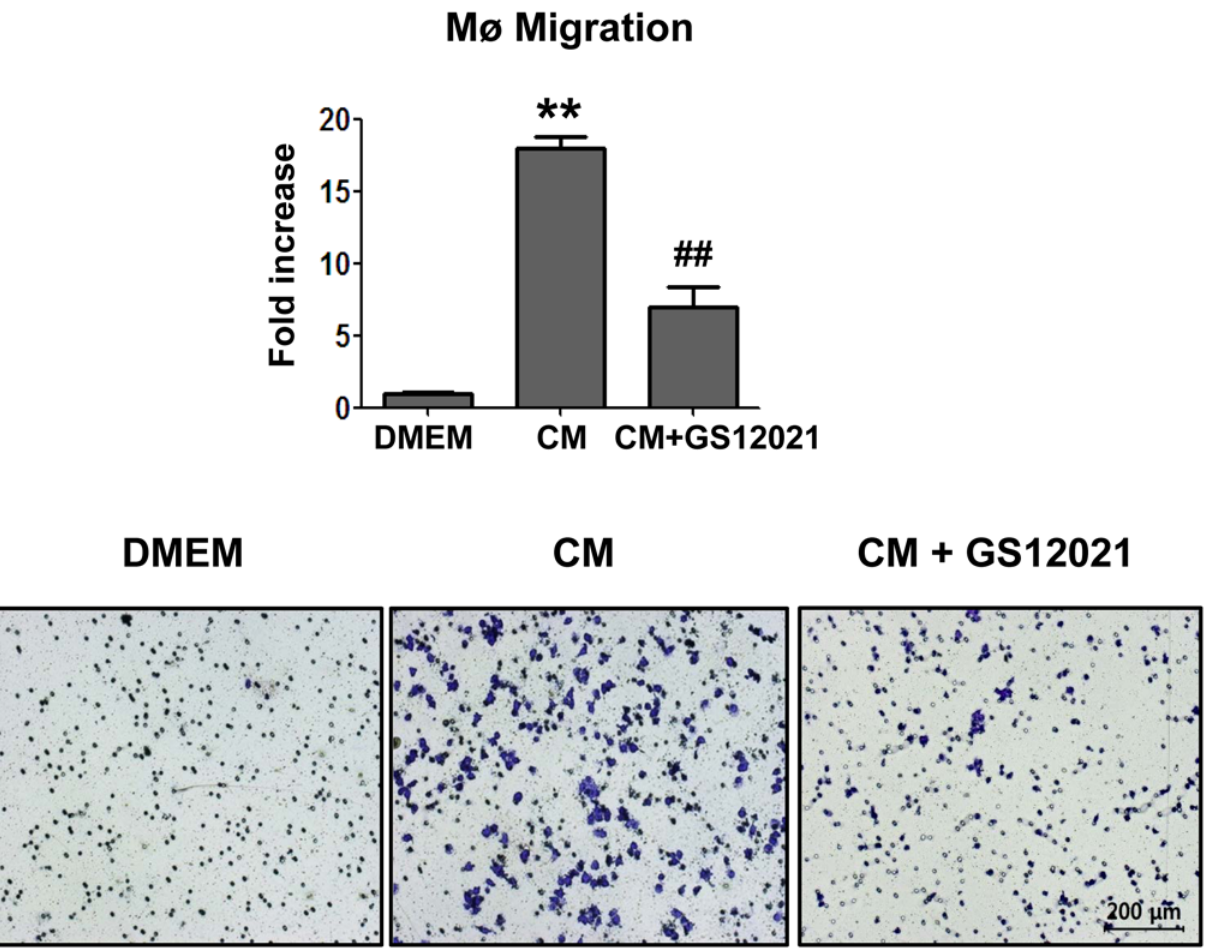
Fig 4. Macrophage chemotaxis was markedly inhibited by GS12021 treatment. Macrophage migration assays using DMEM (migration media) or conditioned medium (CM) collected from adipocytes were conducted. RAW 264.7 cells were incubated with DMSO or GS12021 at 20 μ M for 3 h and detached cells used for the migration assay in the presence of DMEM or CM in the lower well. Cells placed in transwells were incubated for 3 h for migration, and migrated cells found on the lower parts of transwells were counted after staining with crystal violet. The experiments were repeated three times and the representative microscope images for migrated cells are shown below at ×100 magnification. ** P < 0.01 versus DMEM; ## P < 0.01 versus